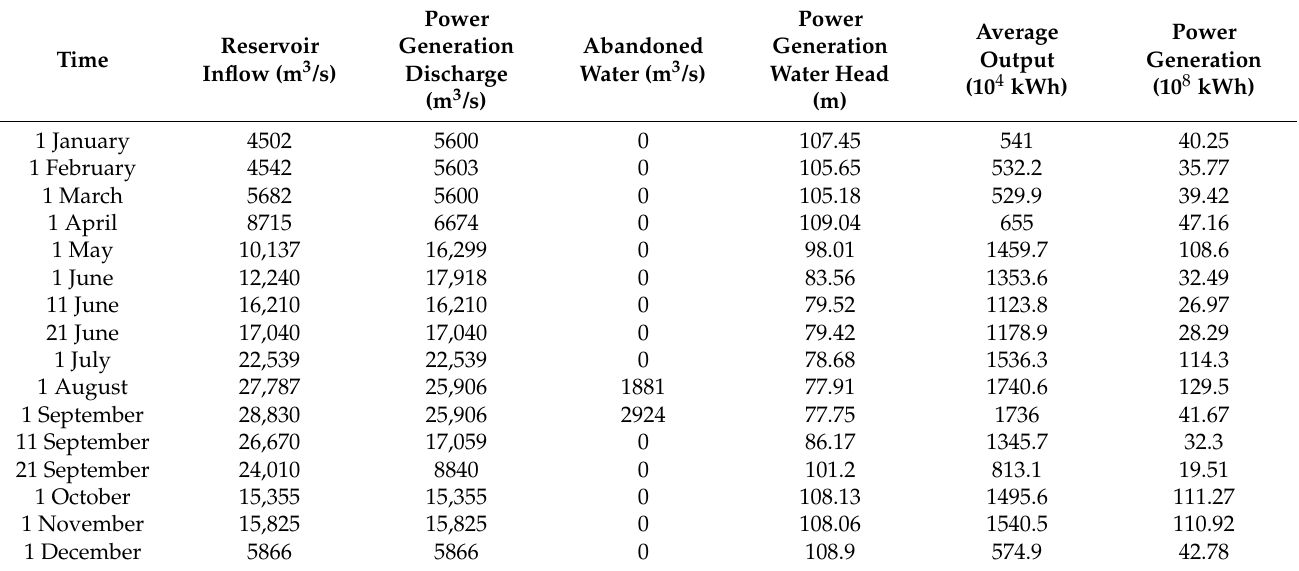
Table 4. Implementation effect statistics of yearly scheduling scheme.